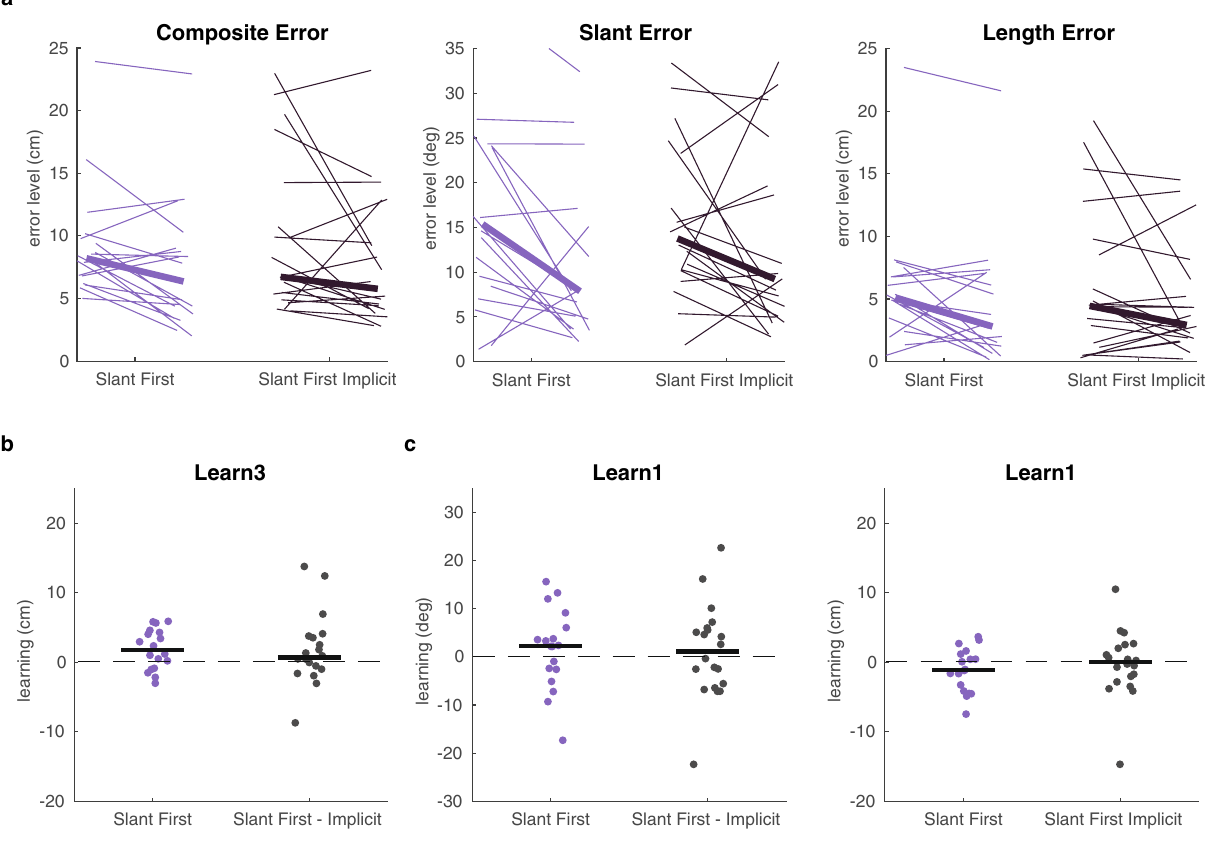
Figure 4. Learning with explicit or implicit feedback on which factor was rewarded. ( a ) Error level in the baseline phase and in the third learning phase for the Slant First group and for the Slant First Implicit group. Thin lines connect for individual participants the error level in the baseline (left) and in the third learning phase (right). Thick lines represent the median for each group. ( b ) Learning of the multidimensional task in the third learning phase. Dots represent individual participants and the black line represents the median across participants. ( c ) Learning of the slant factor and length factor in the first learning phase. Dots represent individual participants and the black line represents the median across participants. For each participant, the horizontal position of the data is the same across all